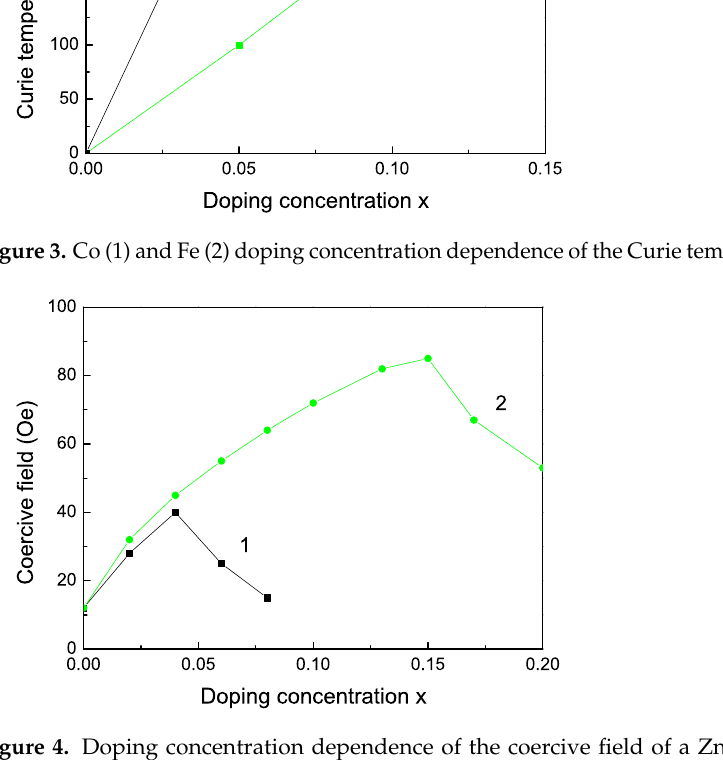
Figure 4. Doping concentration dependence of the coercive field of a ZnS NP for N = 10 shells, T = 300 K for different doping ions: (1) Co and (2) Fe ion